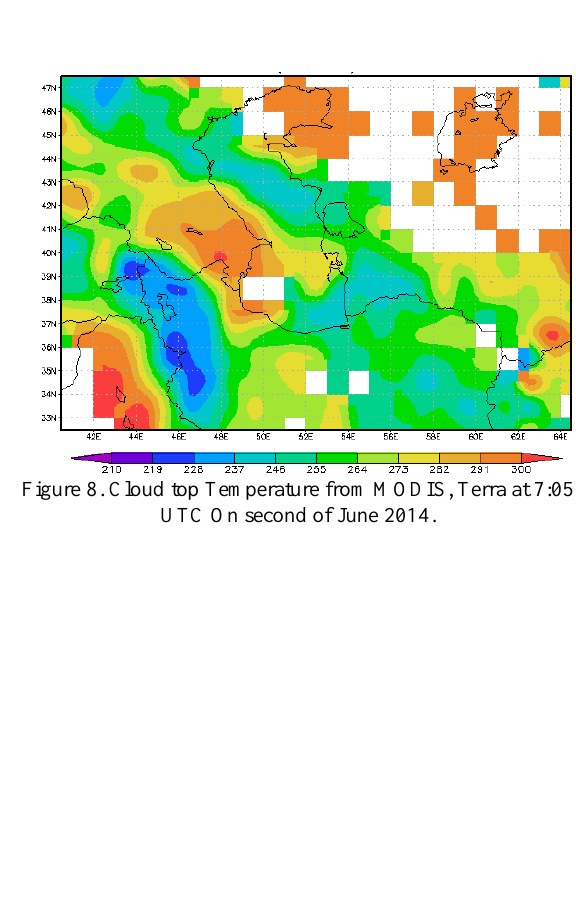
Figure 7. MODIS cloud fraction few hours later from Figure 6 at the day of the storm.